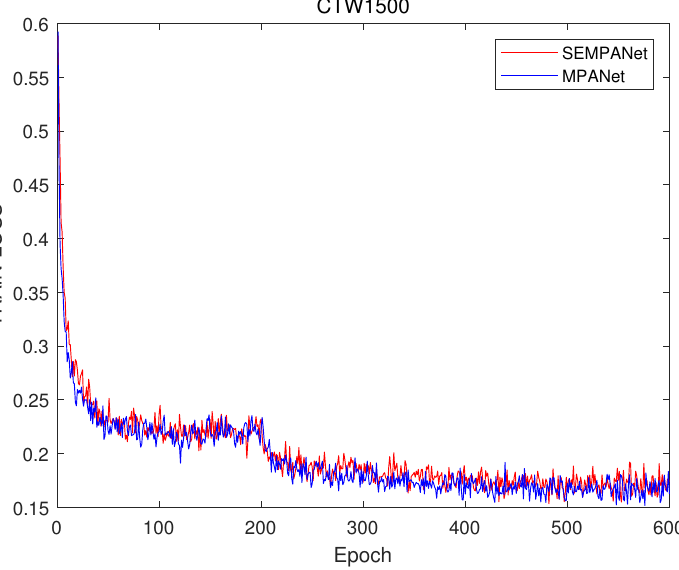
Figure 5. Ablation study of an SE block on CTW1500. These results are based on (ResNet 50 and SE block) and (ResNet 50 block) trained on